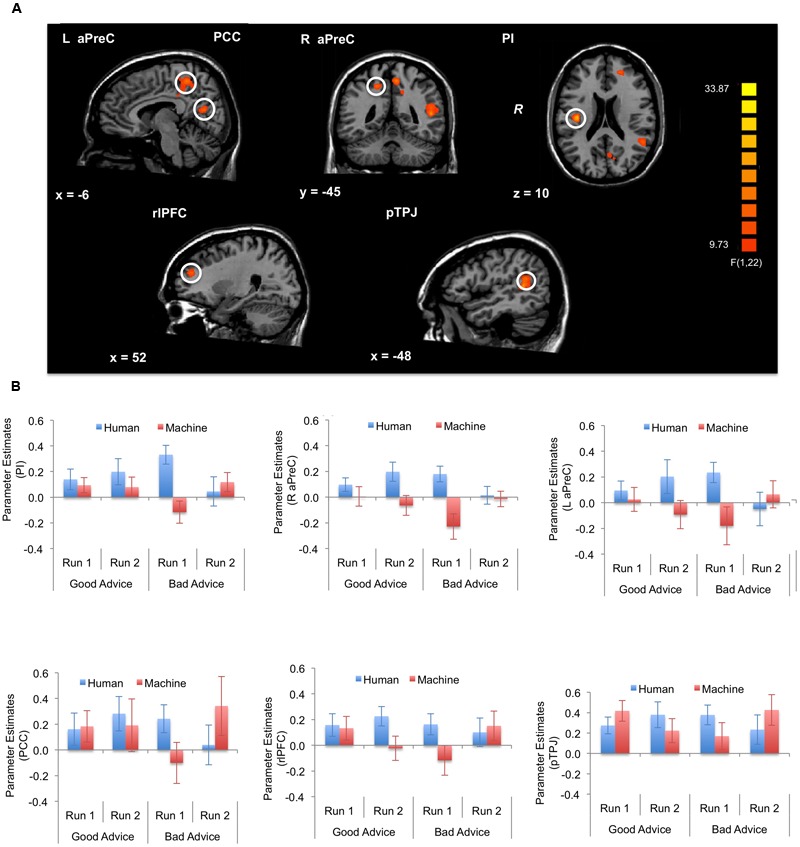
Brain activations during decision phase (α < 0.05, k = 21). The three-way interaction (Advice × Run × Agent) during the decision phase significantly activated the right posterior insula (PI), right anterior precuneus (aPreC), left aPreC, left posterior cingulate cortex (PCC), left rostrolateral prefrontal cortex (rlPFC), and left posterior temporoparietal junction (pTPJ). The activation pattern indicates higher activation for the human- compared to machine-agent group for bad advice during run 1. The bar plots shown are for visualization purposes.